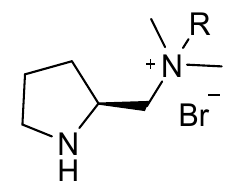
Figure 2. Alkylammonium salts based on L -Proline.